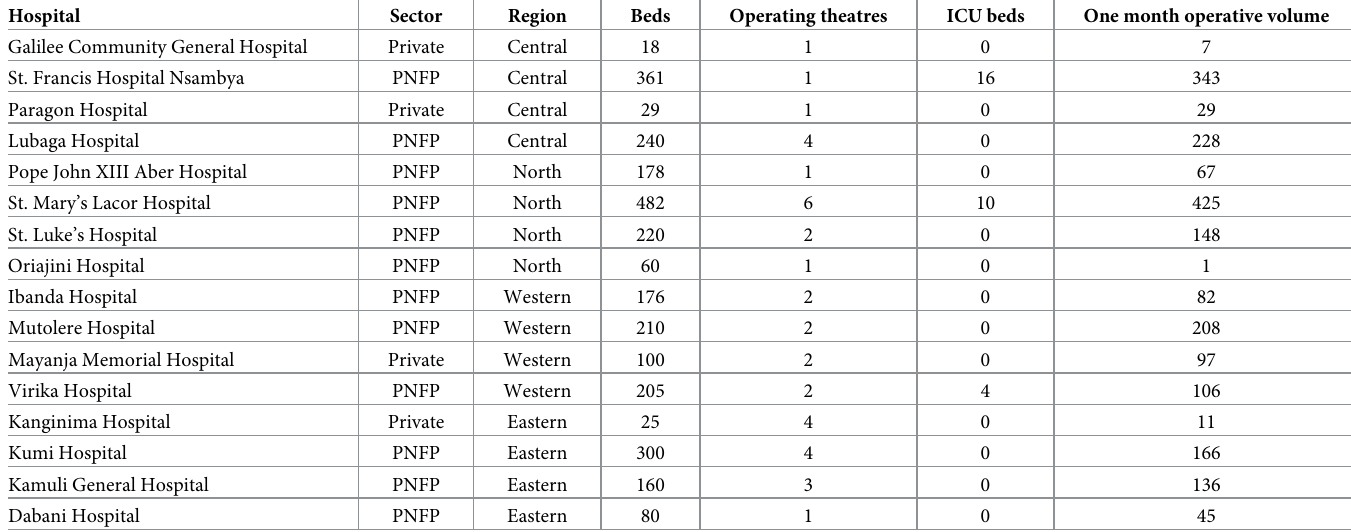
Table 1. Hospital